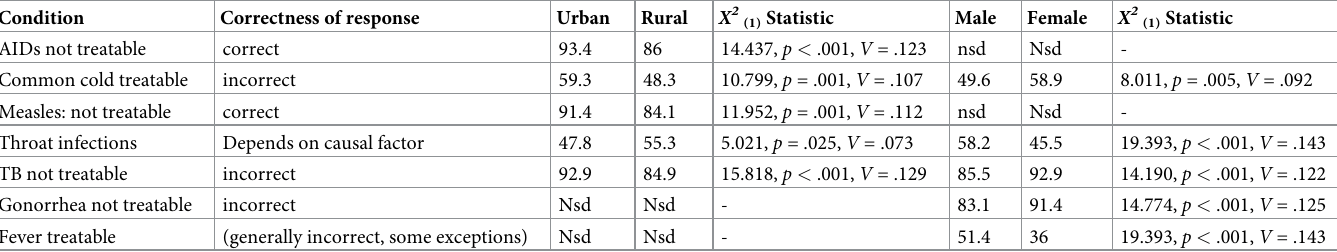
Table 4. Percentages of urban/rural, and male/female students identifying whether conditions are treatable or not with antibiotics.